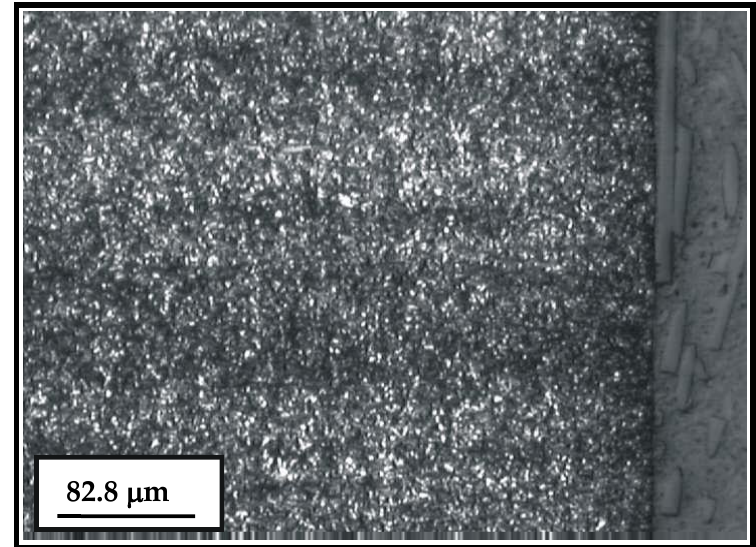
Figure 5. Microstructure of the cemented layer.